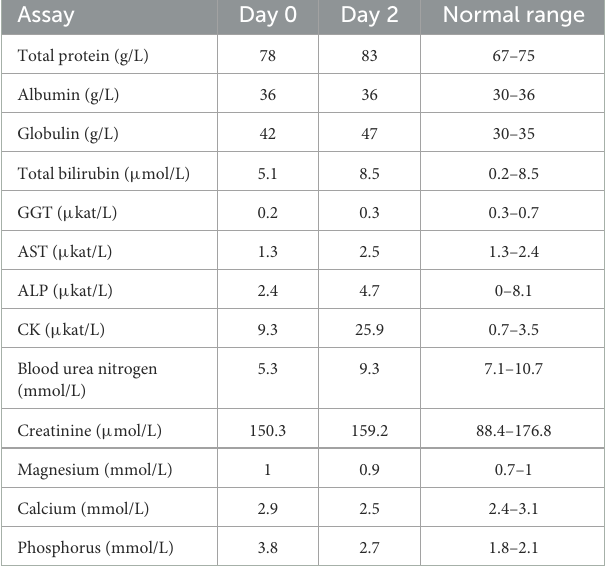
TABLE 2 Serum biochemical analysis results at the tetanus symptom onset and after assuming the lateral recumbent position. Assay Day 0